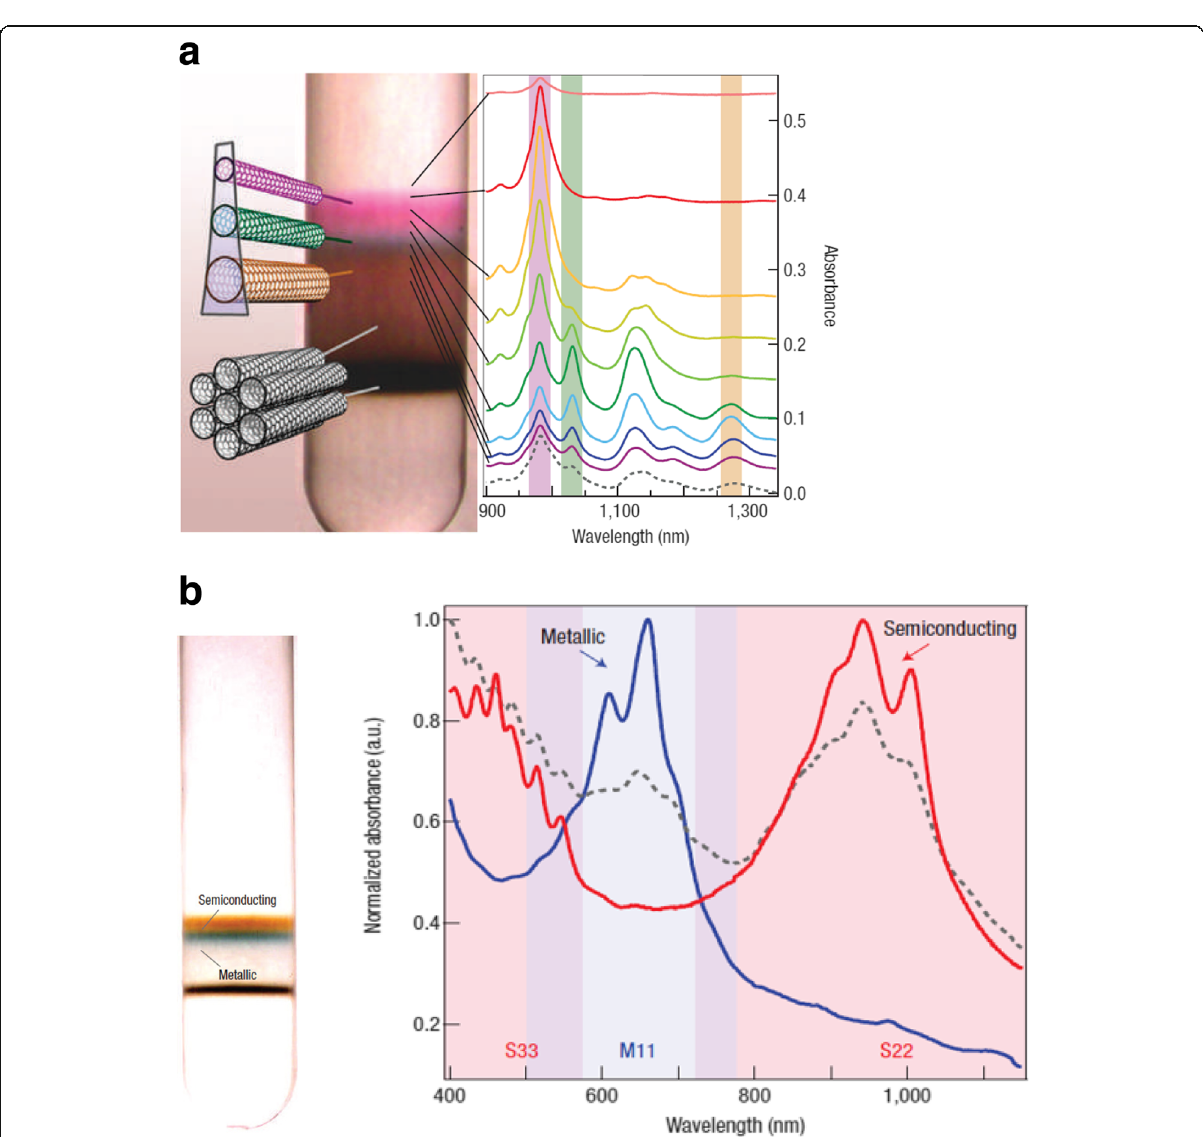
Fig. 21 a Illustration of DGU separation of tubes coated with surfactant based on their diameter and metallicity. The near infrared absorption spectra of SWCNTs is also shown. Adapted from [166]. b Clear separation of SWCNTs by electronic type and the corresponding absorbance spectra for semiconducting SWCNTs (in red) and metallic SWCNTs (in blue) is shown. Adapted from